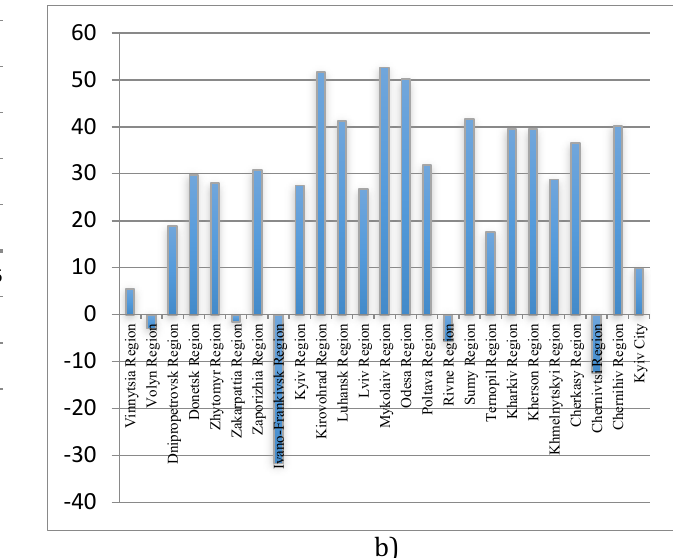
Figure 7: Growth rate of investments in the construction of commercial real estate